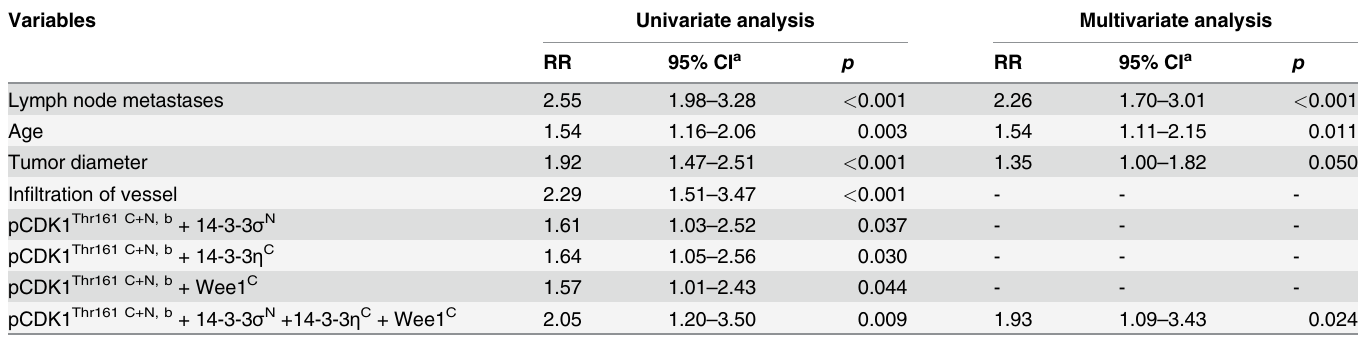
Table 1. Relative risk (RR) of dying from vulvar cancer (all 297 VSCC included).